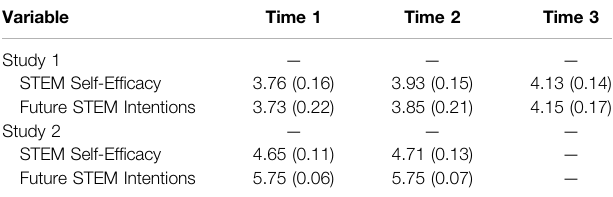
TABLE 4 | Means and Standard